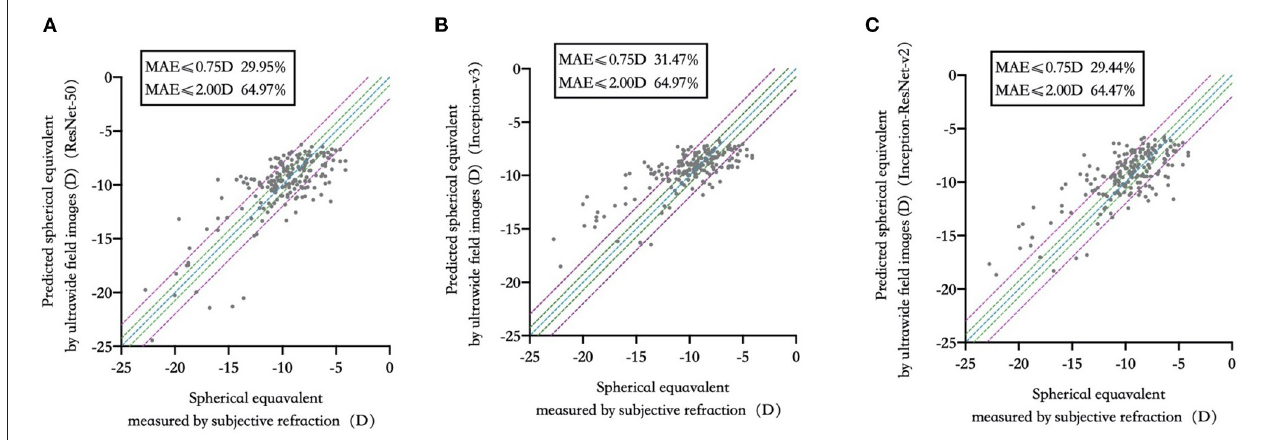
FIGURE 2 | Predicted spherical equivalent versus that measured by subjective refraction in three deep learning models. (A) ResNet-50; (B) Inception-v3; (C)